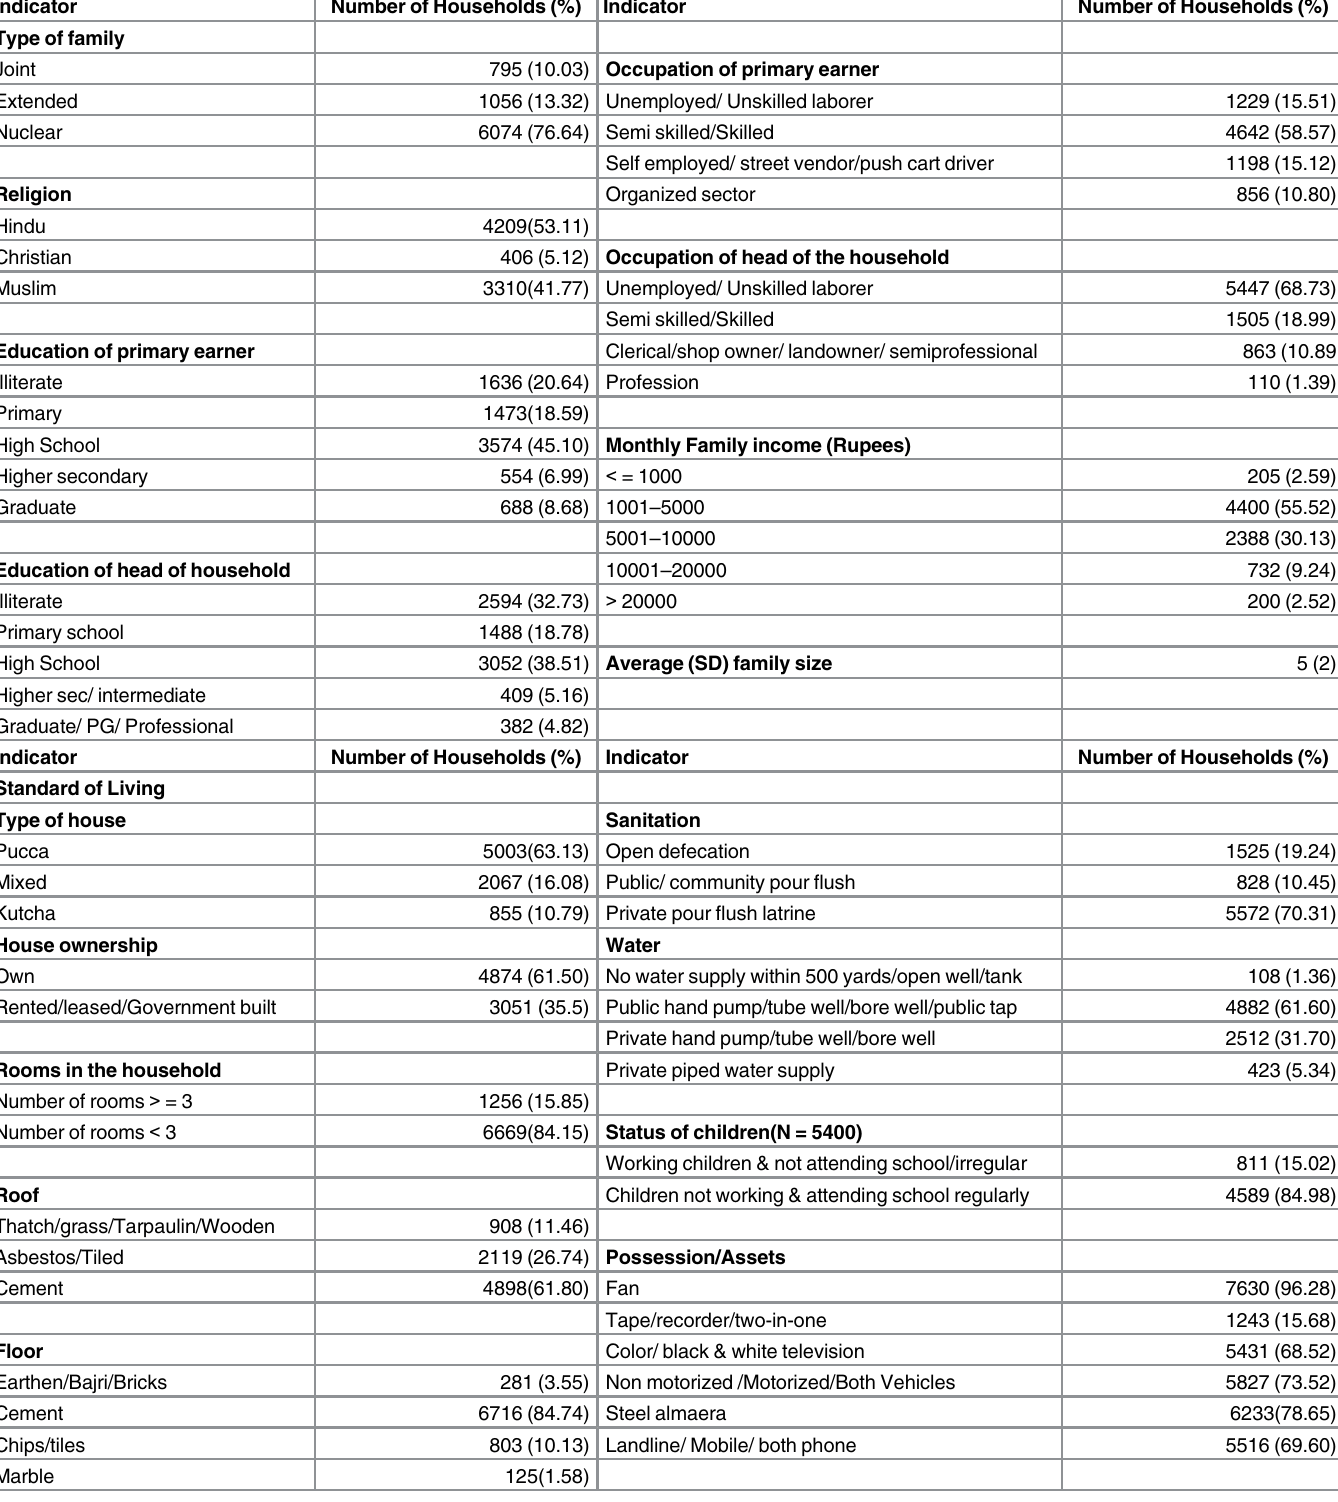
Table 2. Socio- demographic description of the study